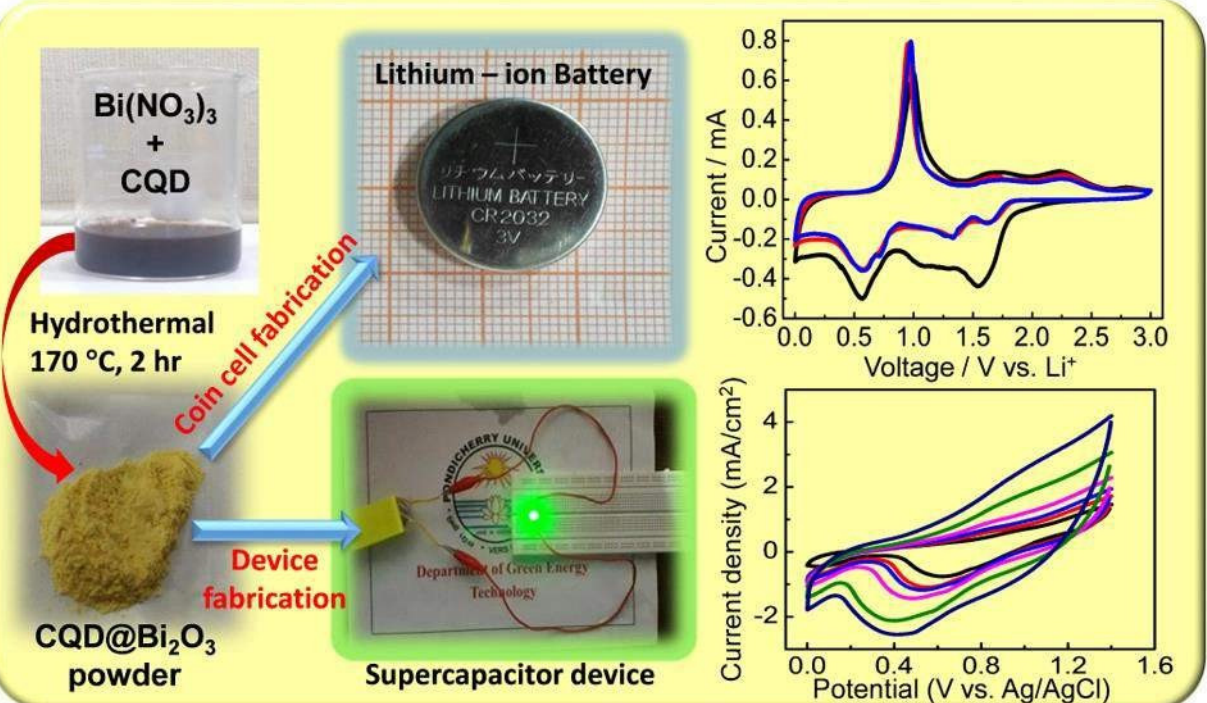
Figure 3. CQD–Bi 2 O 3 composite used as a supercapacitor electrode. Reproduced with permission Figure 3. CQD–Bi2O3 composite used as a supercapacitor electrode. Reproduced with permission from [52]. from